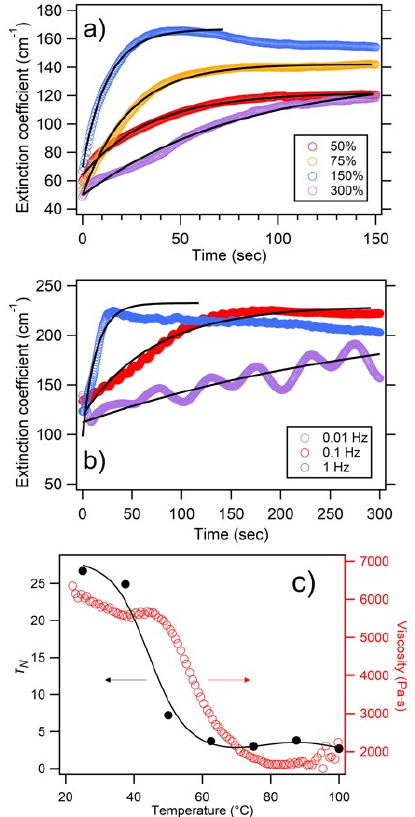
Figure 3. Time evolution of the extinction coefficient at the stopband wavelength of λ = 610 nm at a temperature of 50 ◦ C. This is shown for various shear amplitudes at frequency 1 Hz in ( a ), and for various oscillation frequencies at a shear amplitude of 150% in ( b ), as indicated. Exponential trend lines are used to extract shear-ordering timescales, as limited to the illustrated range of fitting. ( c ) Shows the temperature dependence of experimentally derived τ N values for parameters of frequency = 1 Hz and strain = 100%, in comparison to the rheometrically measured viscosity. An indicative trendline is added to the former, using smoothing spline